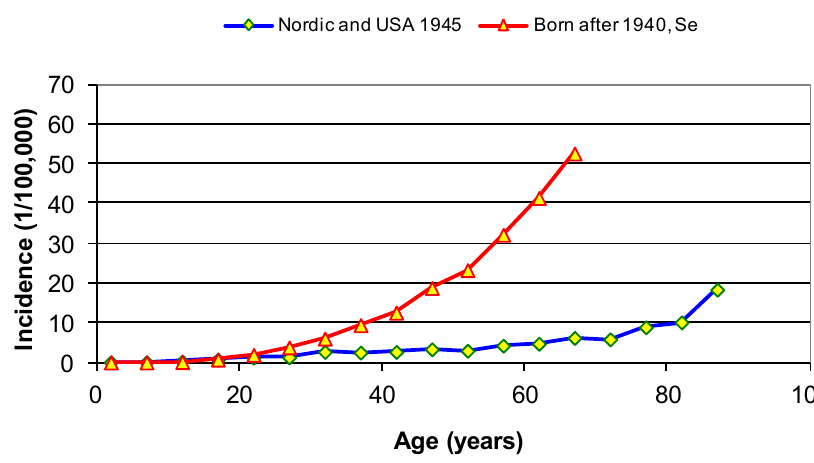
Figure 2. Melanoma incidence versus age in the Nordic countries and USA before 1950. Also shown is the melanoma incidence of birth cohorts born in 1940 and later in Sweden. From [2].